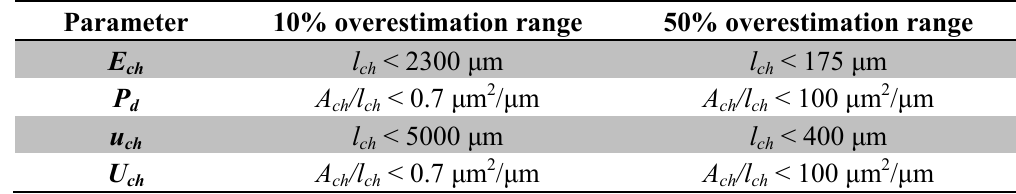
Table 1. The overestimation error ranges for a practical microchannels when the expressions for an ideal microchannel are